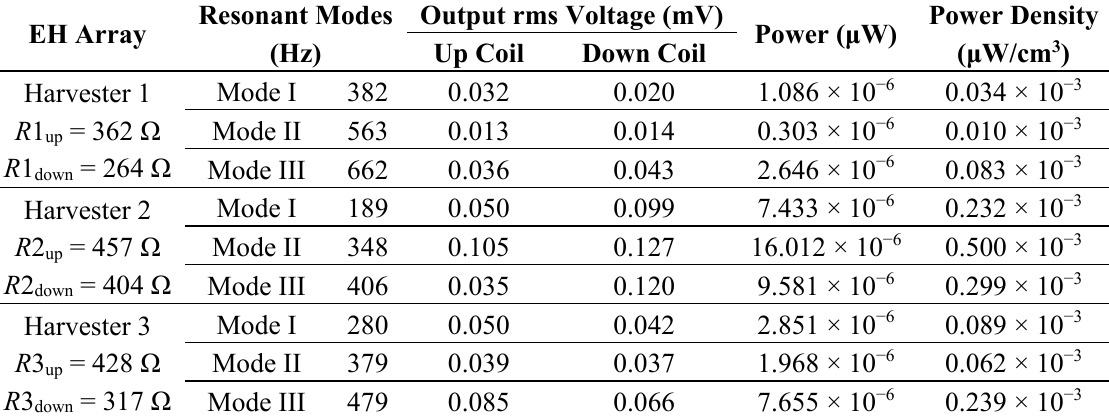
Figure 4. The output voltages of the EH array against frequencies for ( a ) up and ( b ) down coils at acceleration of 1 g along x -axis. Table 2. Output performance summary of the EH array